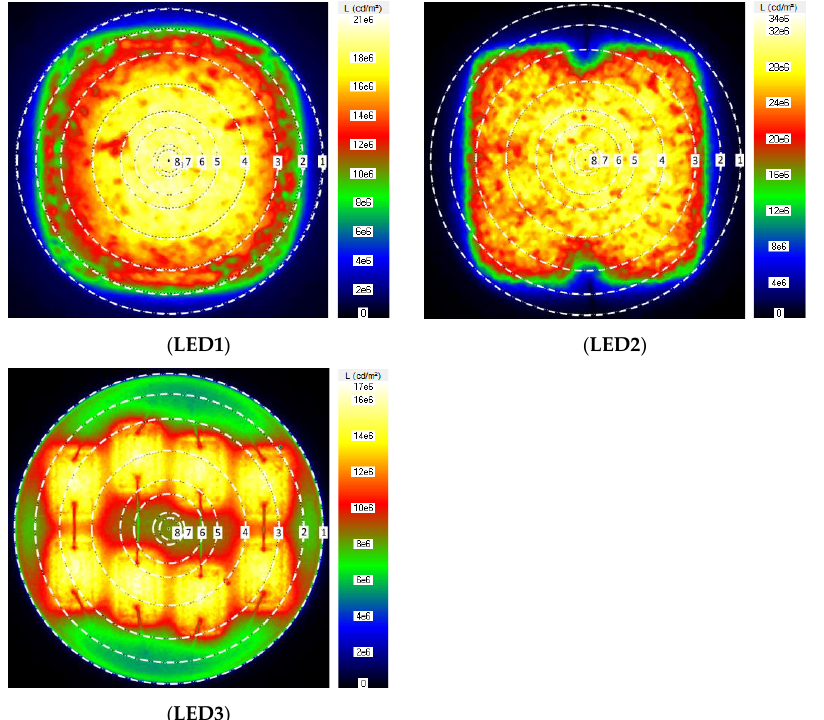
Figure 6. LED1, LED2, and LED3, with the eight measurement areas plotted, on the luminance distributions from the direction of the optical axis (C0 γ 0).